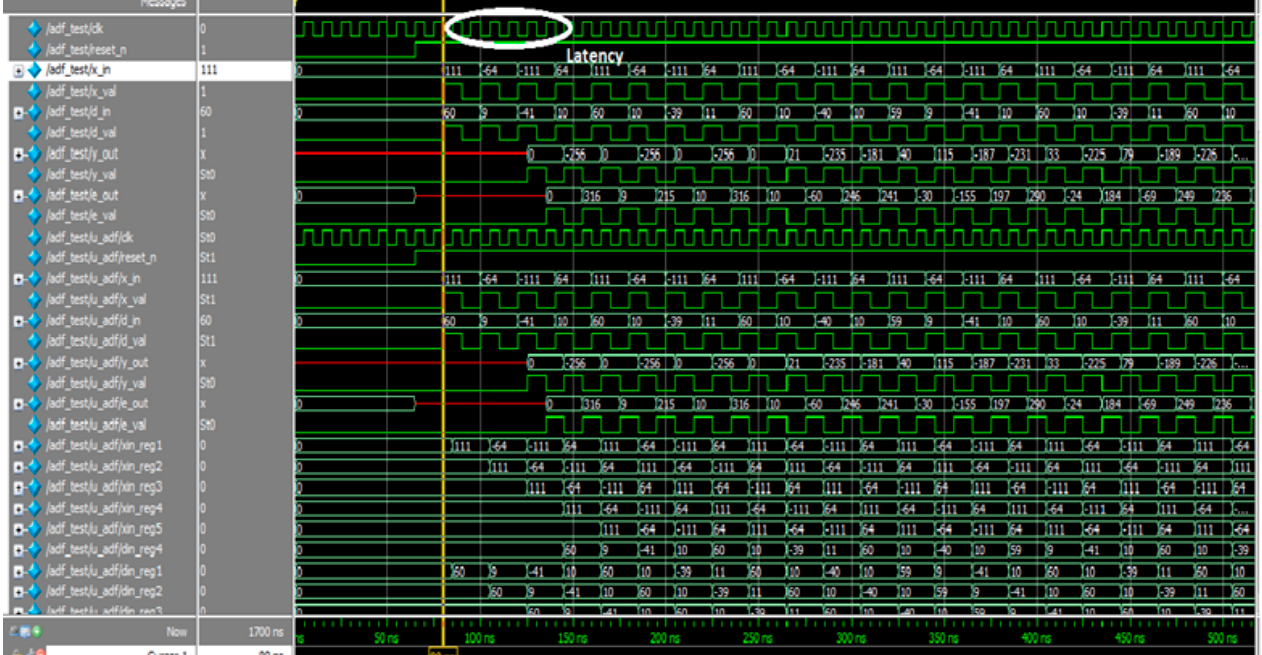
Figure 9. Figure simulation waveform of proposed single MAC ADALINE filter.